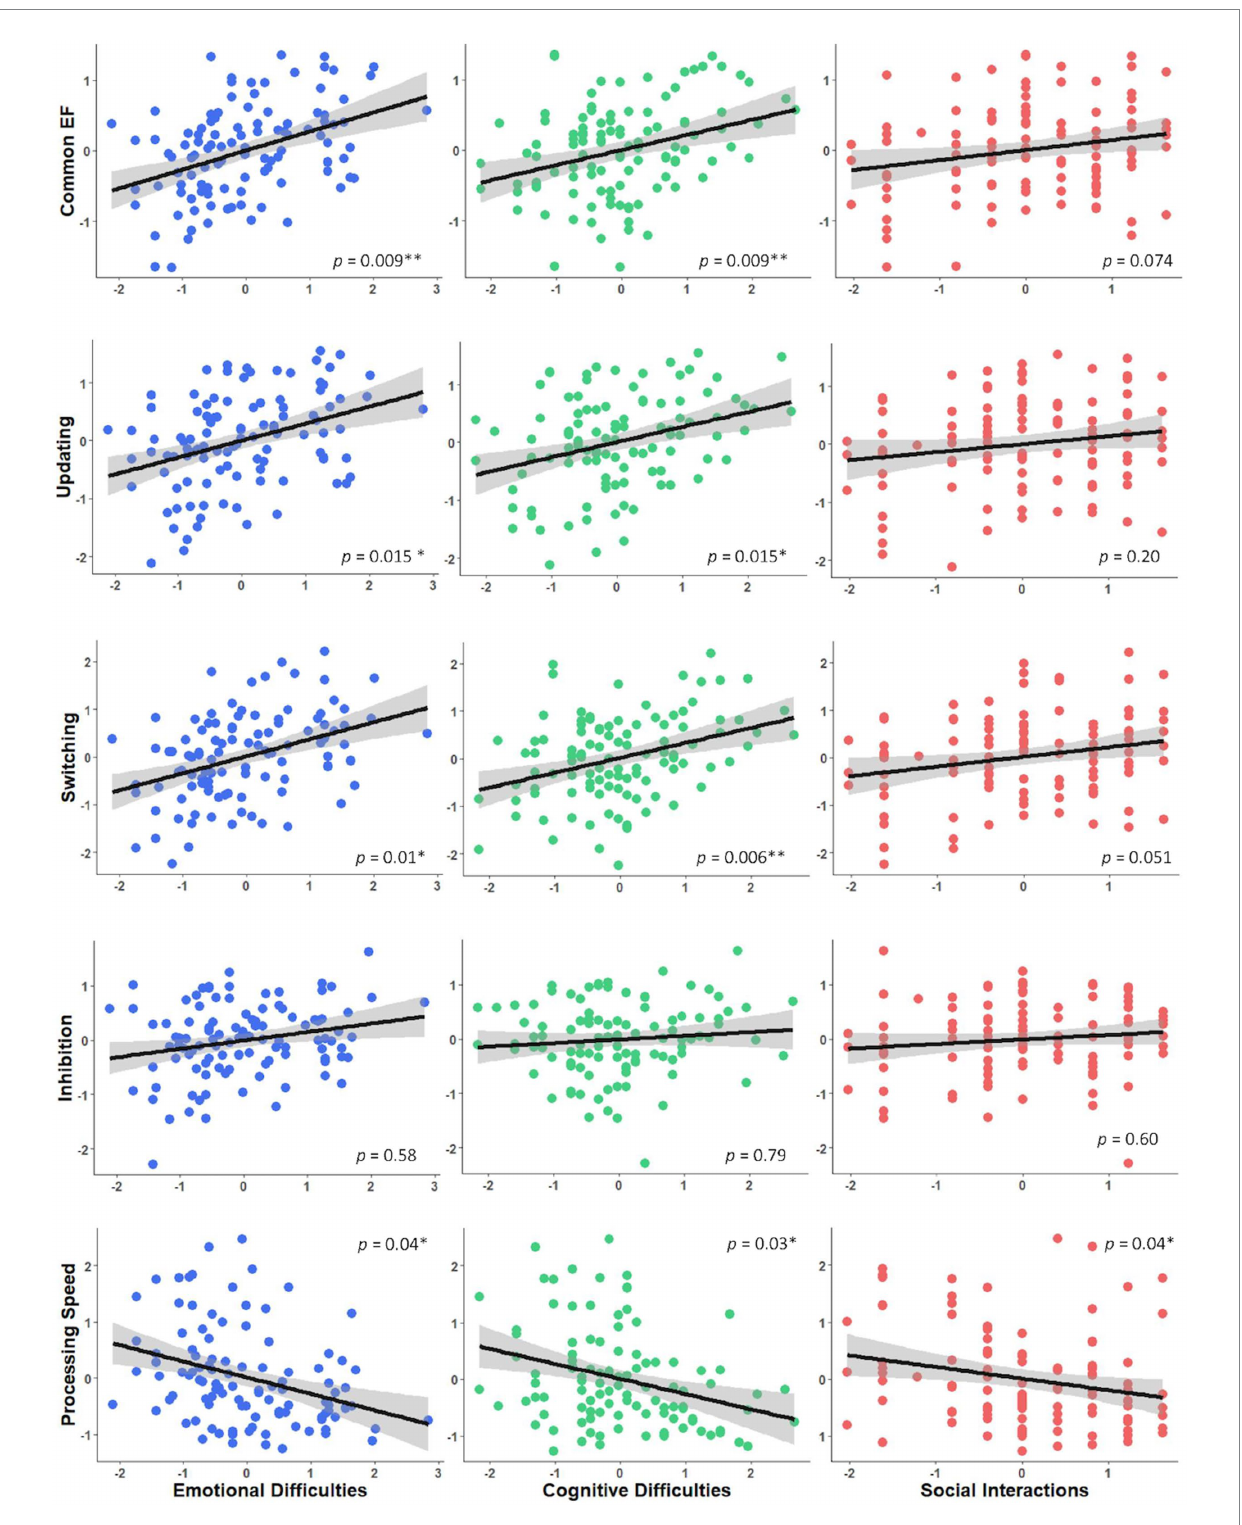
FIGURE 1 EF and processing speed as predictors of mid-pandemic functioning. Common EF, and subdomains of inhibition, updating, and switching as predictors of higher social, and worse cognitive and emotional experiences at the COVID-19 pandemic second time point survey (January– March 2021). The relationships are displayed without age regression, while all reported statistics had age as a covariate. Higher processing speed scores reflect slower speeds. The y-axis labels (e.g., updating) refer to the predictor measures across the entire respective row, while the x-axis labels (e.g., Emotional Difficulties) apply the outcomes for all graphs in that respective column. ** p < 0.01, * p < 0.05, all FDR